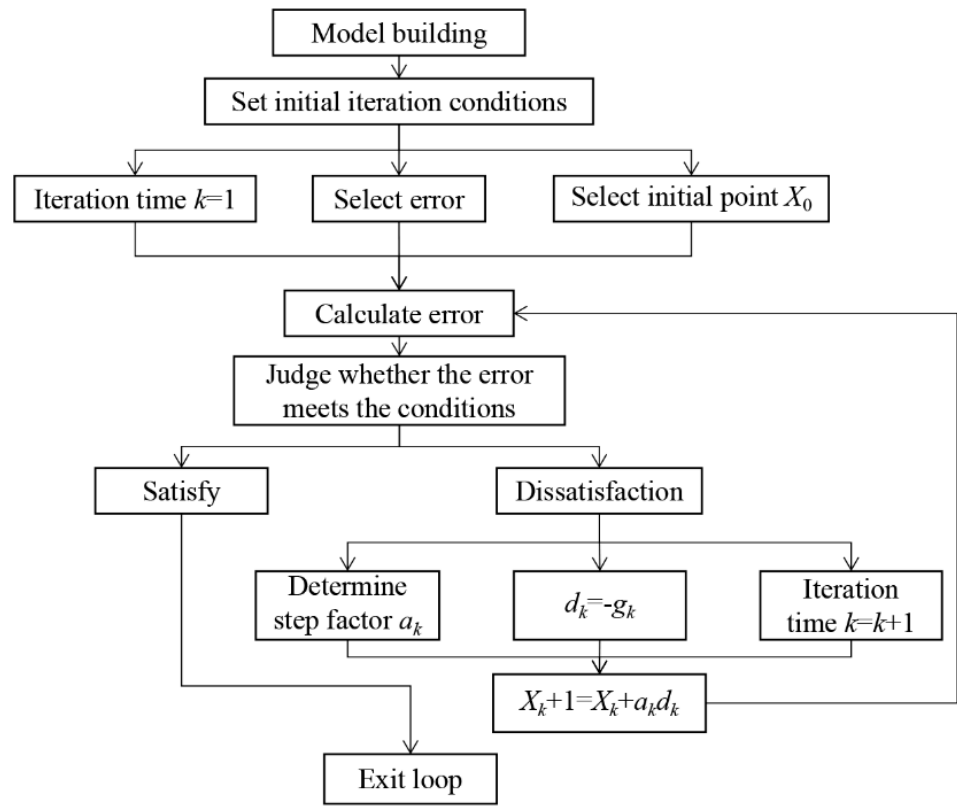
Figure 16. Schematic of Lorenz coefficient optimization in waterflood reservoir.